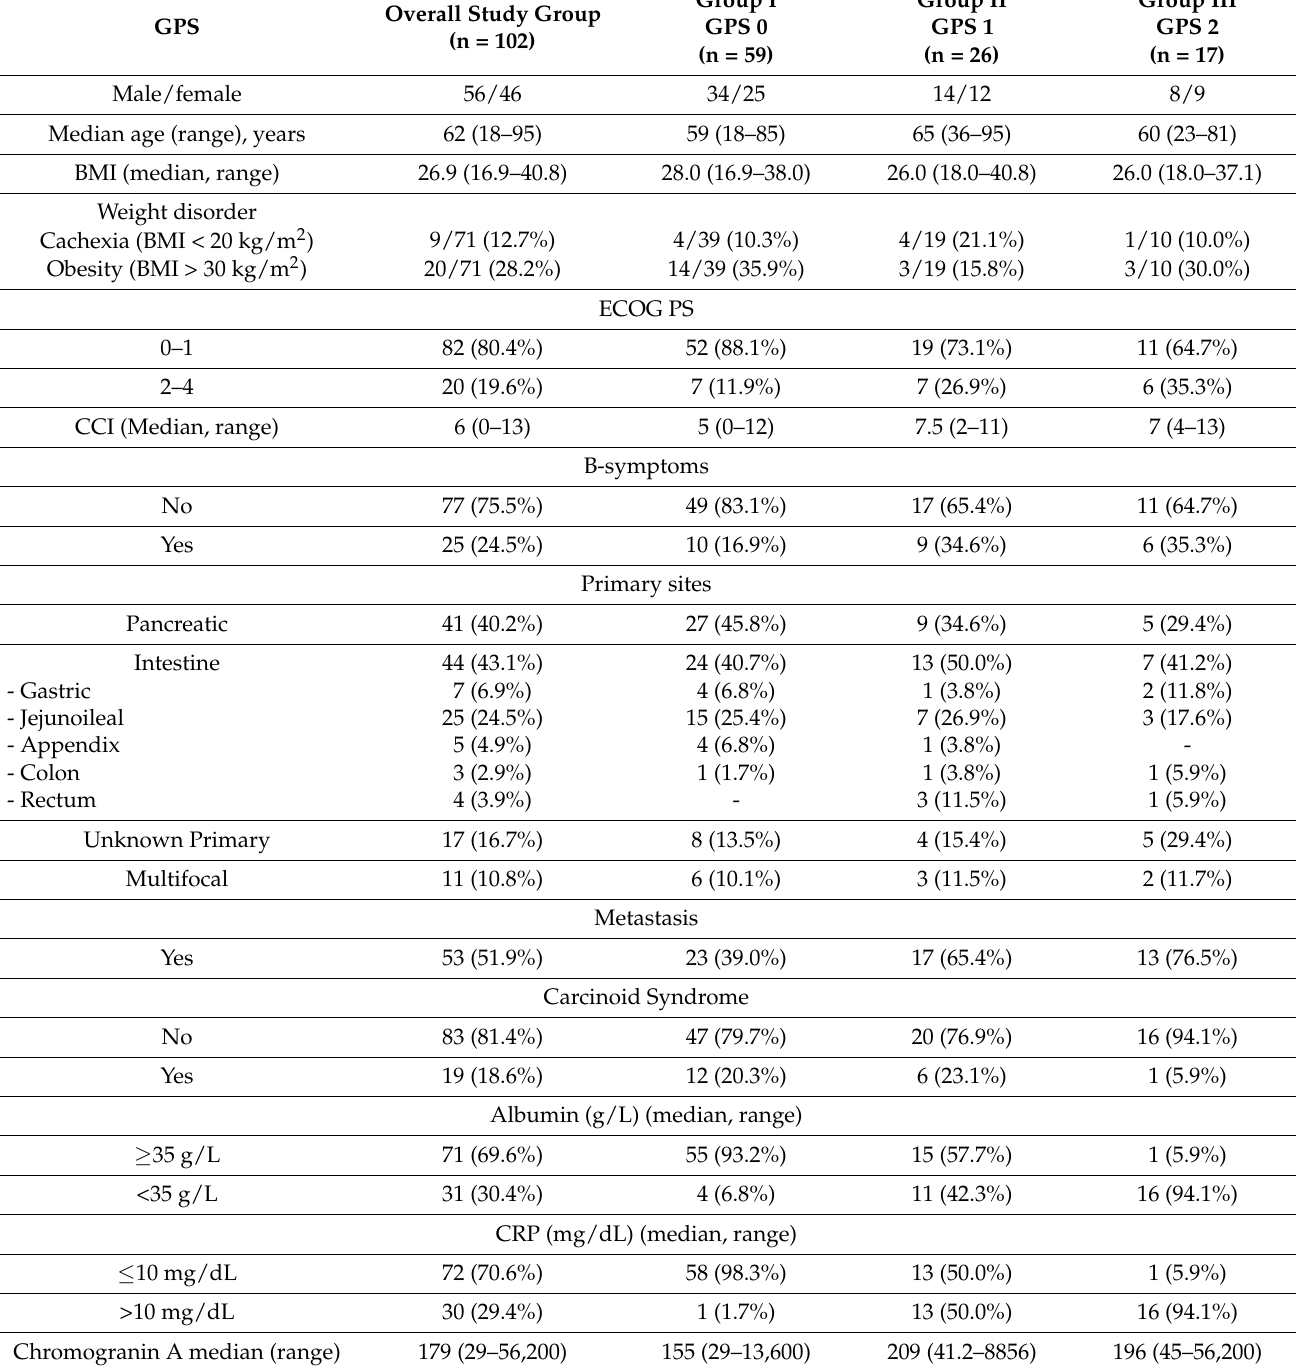
Table 2. Baseline clinicopathological characteristics in the current study